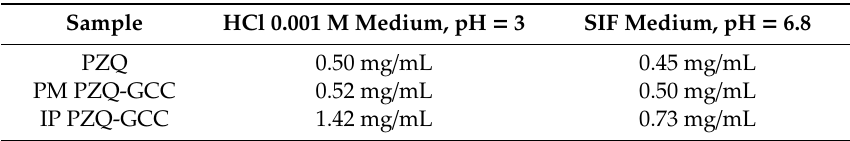
Table 1. Solubility values of praziquantel (PZQ), physical mixture (PM) of PZQ-GCC and interaction product (IP) of PZQ-GCC in acid and simulated intestinal fluid (SIF) media (mean values ± standard deviation; n =